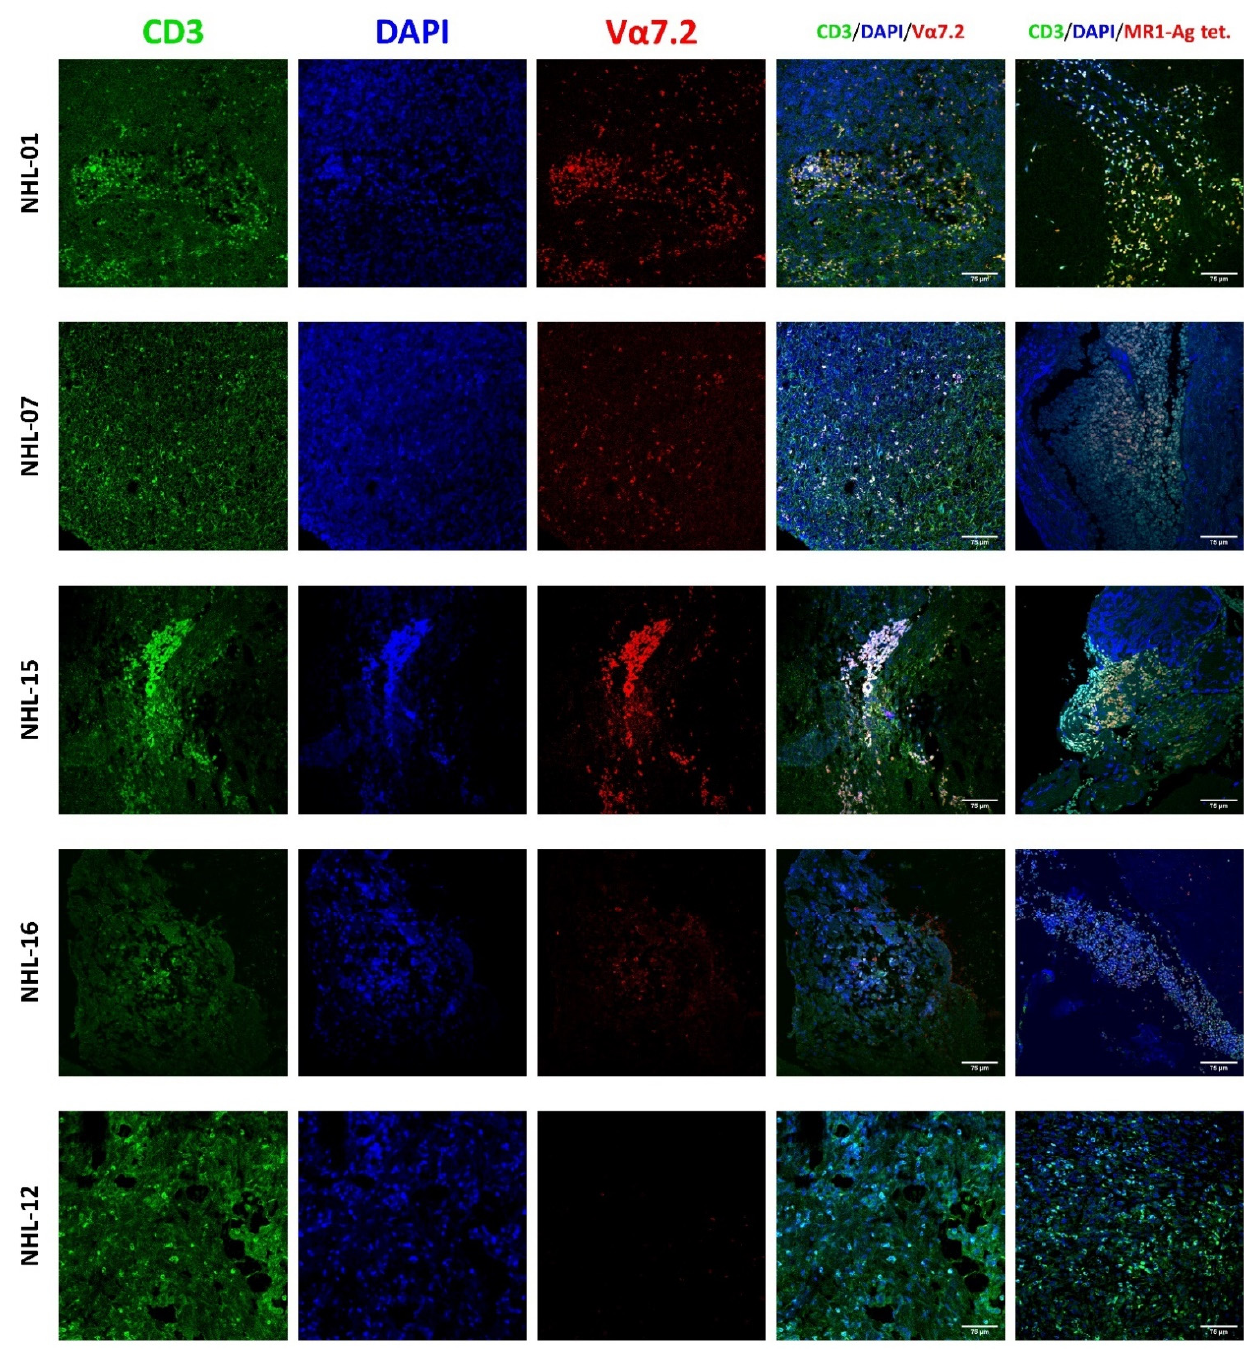
Figure 2. Immunofluorescence staining for MAIT cells detection. Tissues were stained for CD3 (green signal), V α 7.2, or MR1-Ag tetramer (red signal), and nuclei were stained using 4 (cid:48) ,6-diamidino-2-phenylindole (DAPI; blue signal). Immunofluorescence staining showed colocalization of CD3/V α 7.2 or MR1-Ag tetramer in biopsies of NHL-01, NHL-07, NHL-15, and NHL-16. NHL-12 is displayed as a negative case.